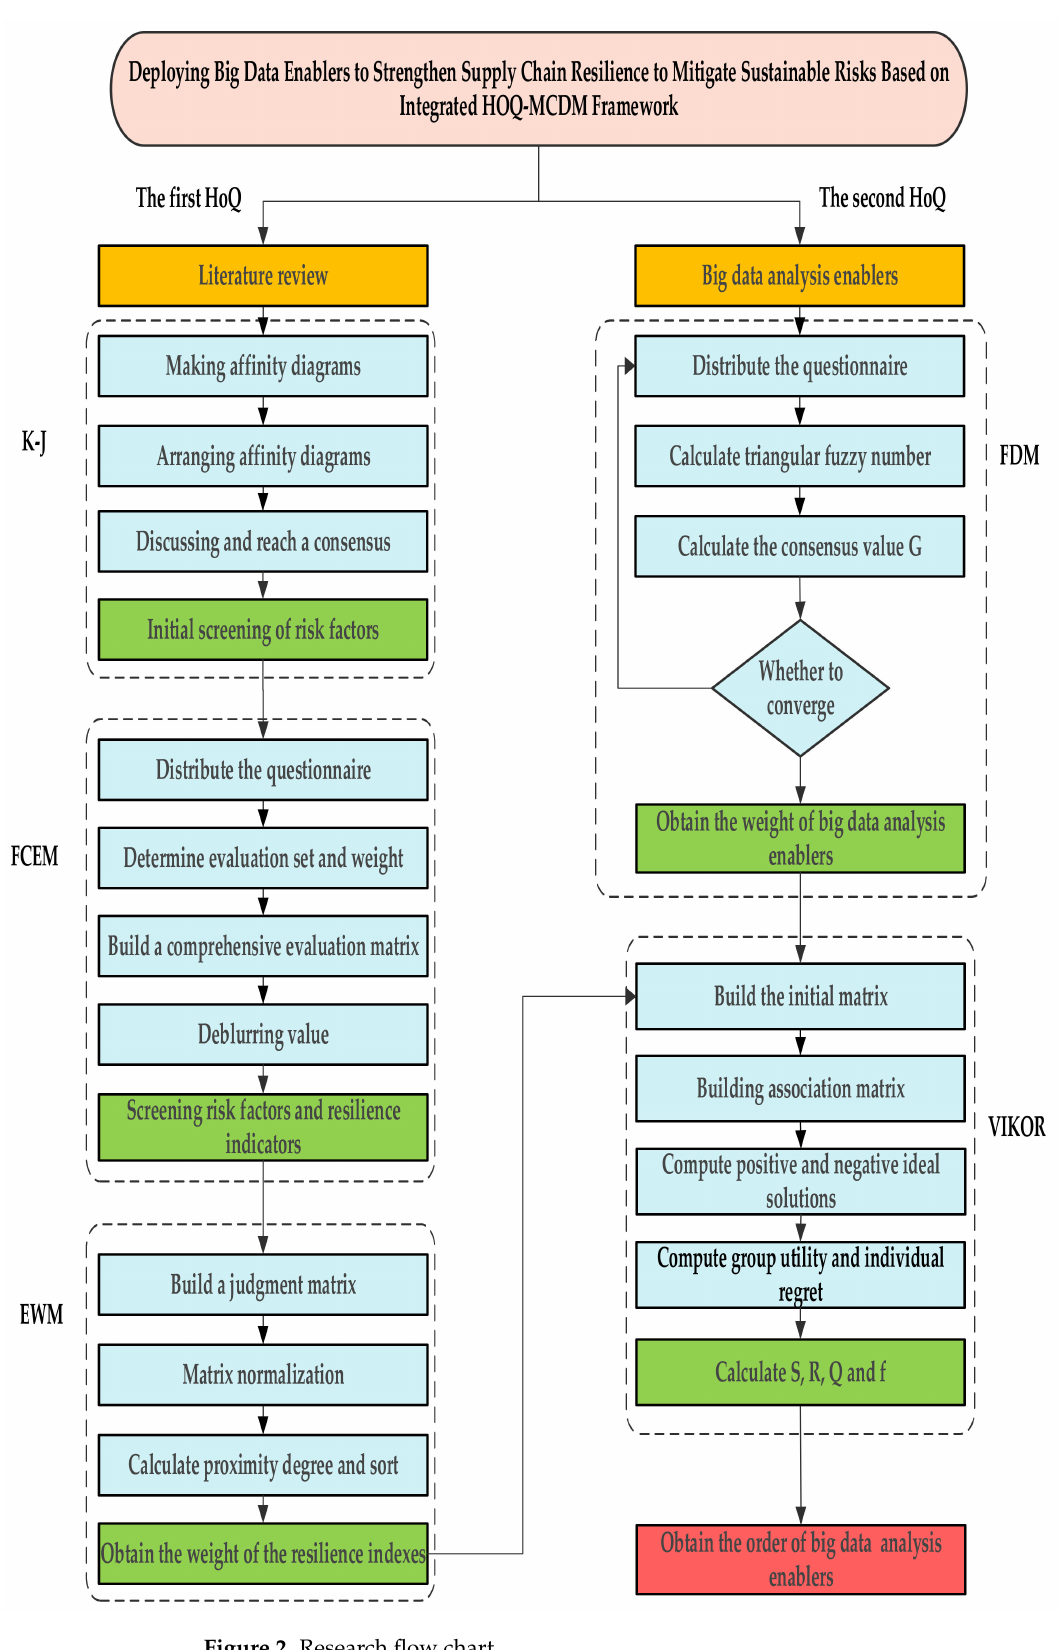
Figure 2. Research flow